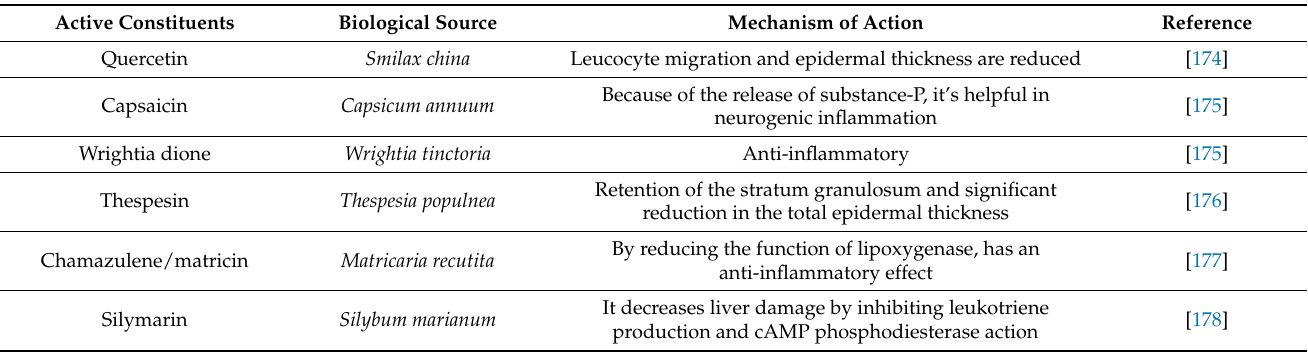
Table 4. Phenolic compounds in psoriasis treatment